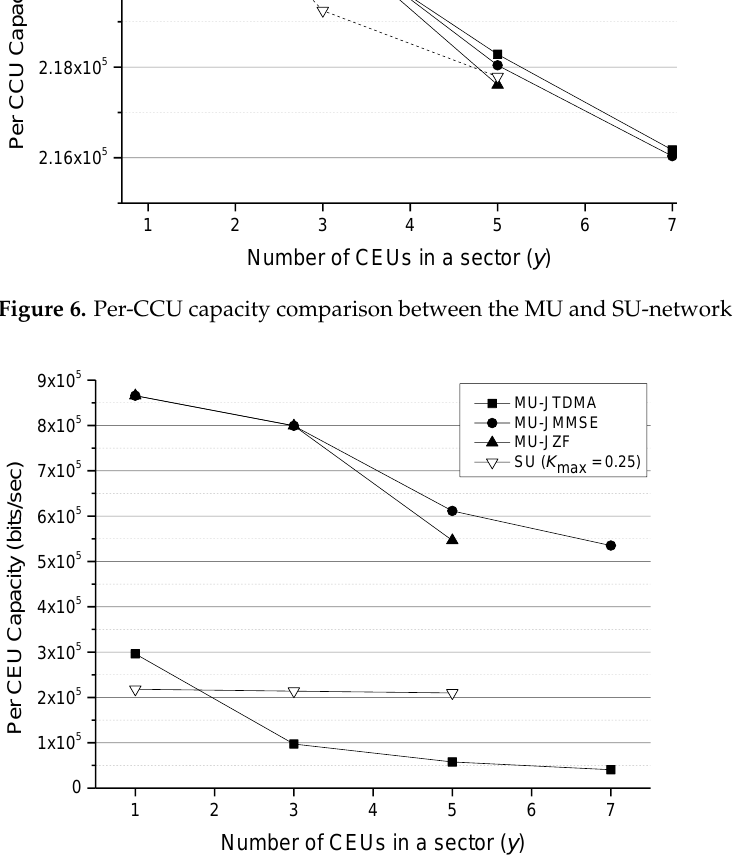
Figure 7. Per-CEU capacity comparison between the MU and SU-network MIMO.